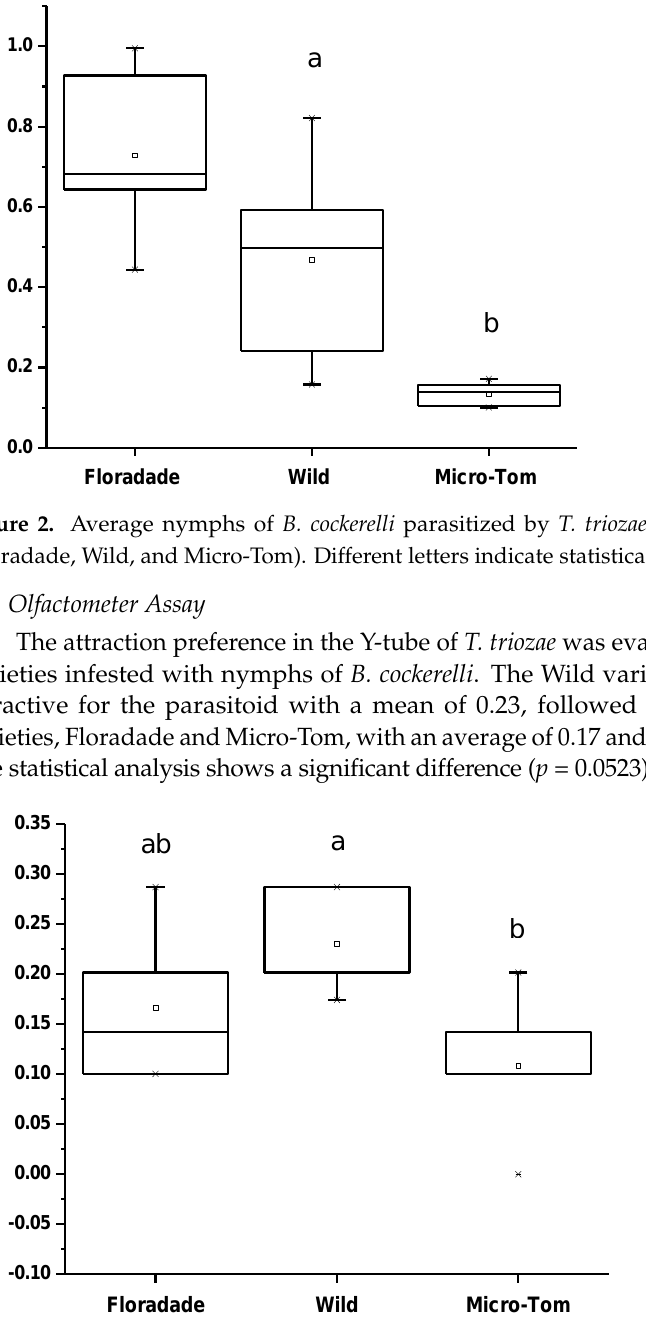
Figure 1. The number of eggs of B. cockerelli in tomato plants of three varieties (Floradade, Wild, and Micro-Tom). Different letters indicate statistical differences ( p < 0.05).